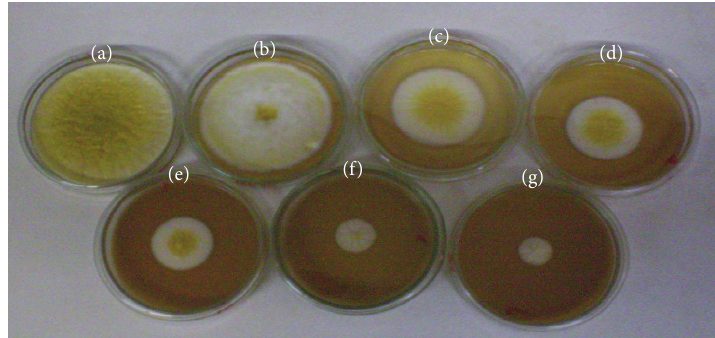
Figure 1: Effect of essential oil from C. longa on A. flavus mycelial growth in YES medium ((a) positive control, (b), (c), (d), (e), (f), and (g) treatments with essential oil from C. longa at 0.10, 0.25, 0.50, 1.0, 2.5, and 5.0%, resp.).